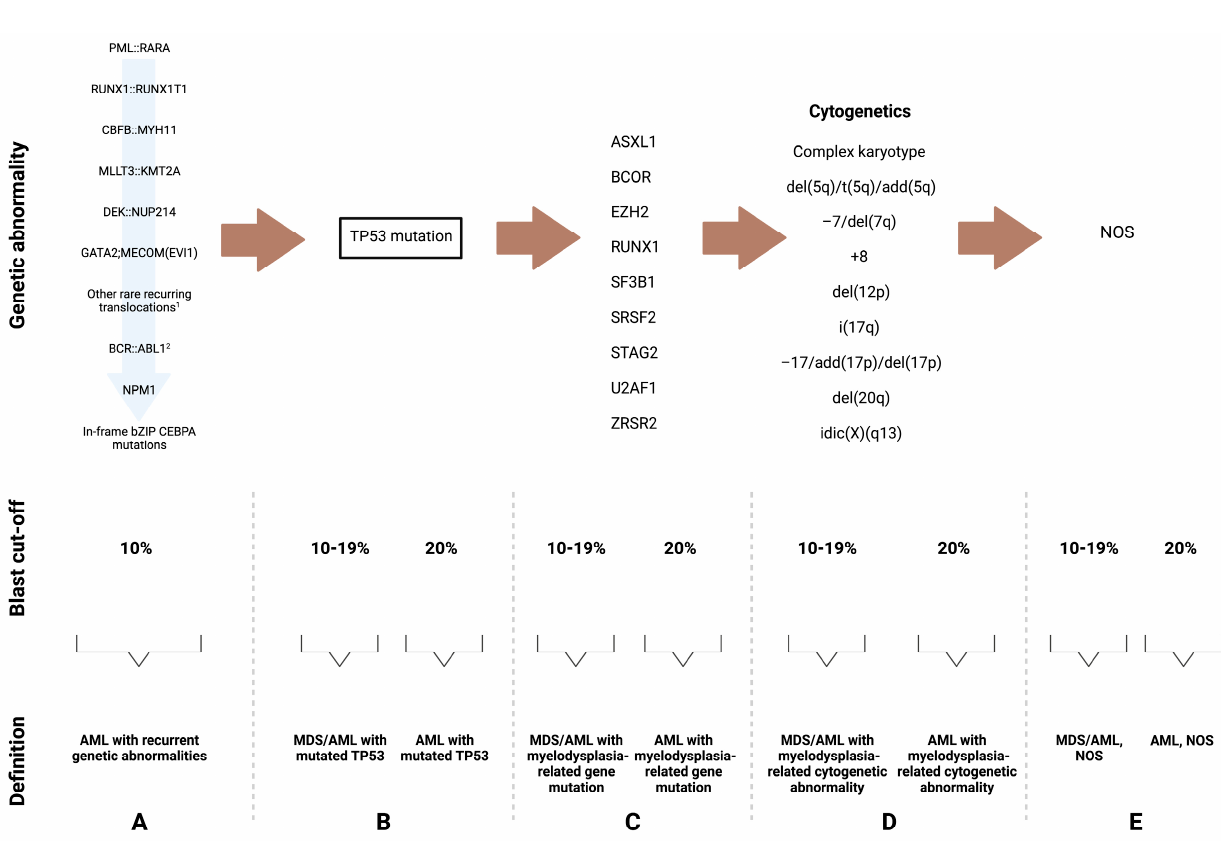
11 of 26 Figure 1. The classification algorithm of MDS based on the new changes. 1 Diagnosis of MDS/AML or AML with mutated TP53 can be made with any somatic TP53 mutation with VAF > 10%, whereas MDS with mutated TP53 requires the presence of a multi-hit TP53 mutation or a TP53 mutation (VAF > 10%) and a complex karyotype, often with loss of 17p if LOH information is not available.